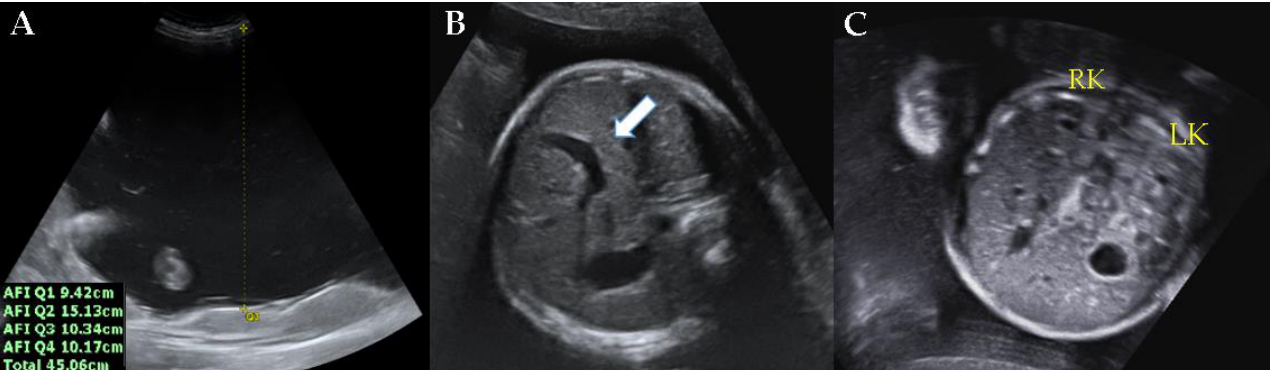
Figure 1. Ultrasonographic findings at 31 weeks of gestation. ( A ) Amniotic fluid index was 45.06 cm. ( B ) Persistent right umbilical vein (arrow) was observed. ( C ) There were no specific findings in either kidney of the fetus. AFI, amniotic fluid index; LK, left kidney; RK, right kidney.